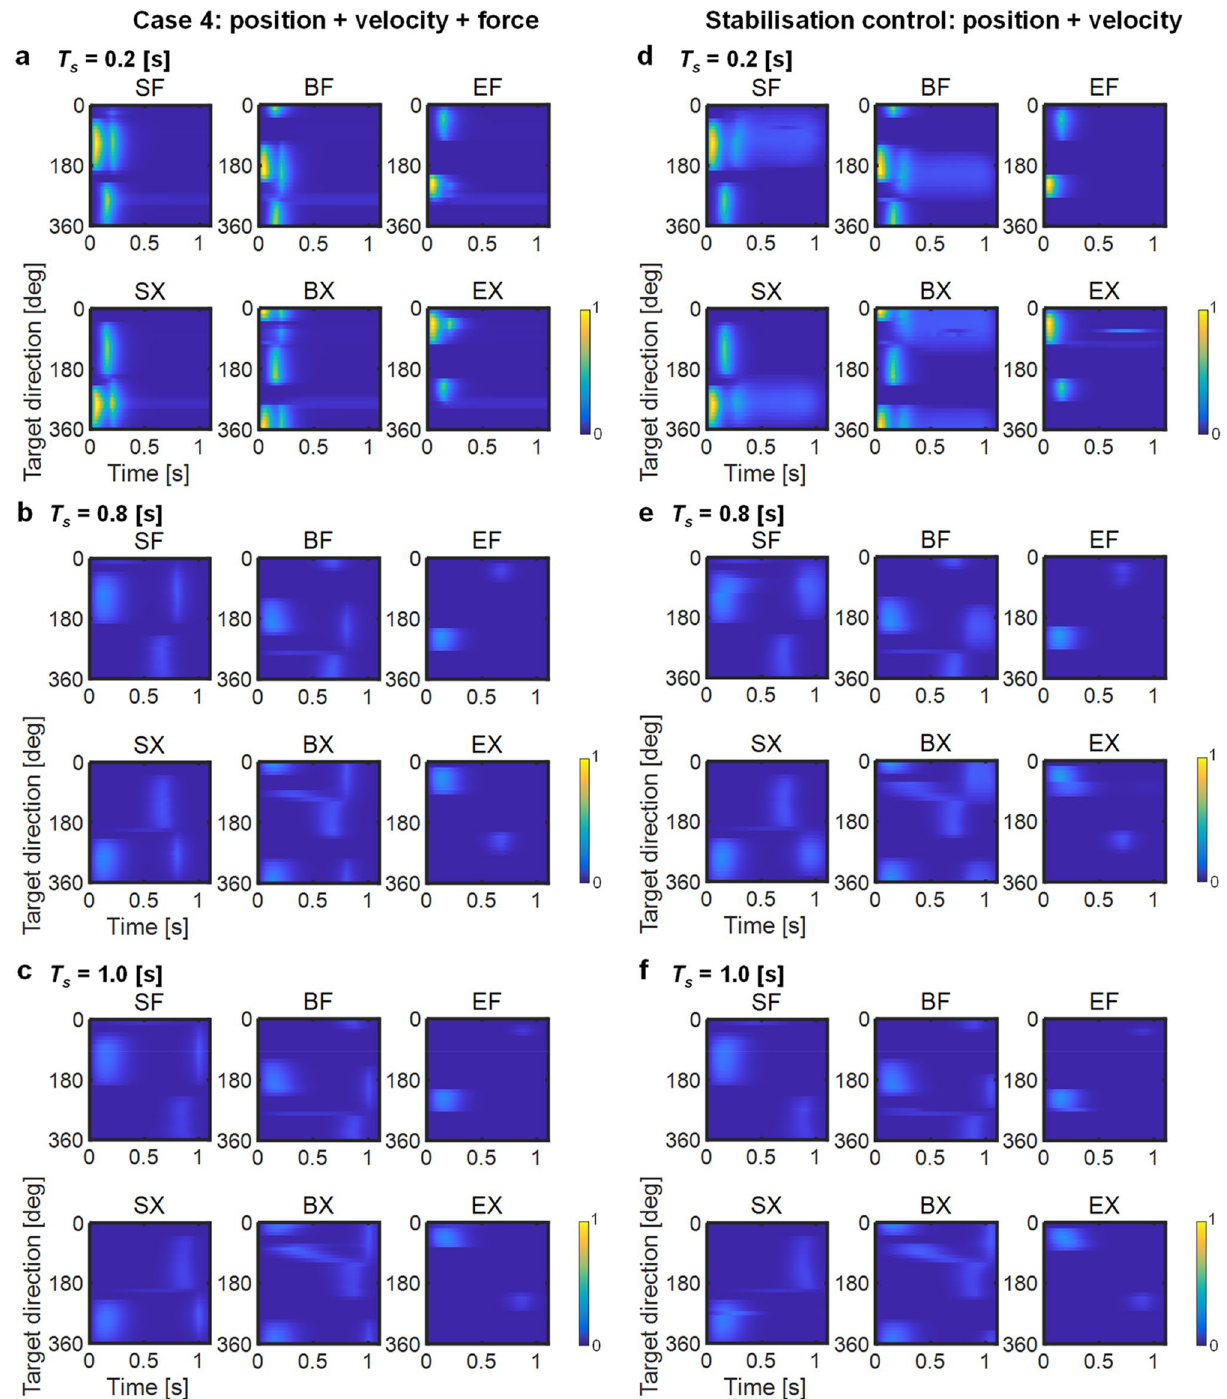
Figure 6. Changes of muscle activation patterns in relation to movement duration. Muscle activation patterns of movement times at 0.2, 0.8, and 1.0 s are shown from top to bottom, respectively. Case 4 and the stabilisation control are shown in ( a – c ) and ( d – f ), respectively. Values were normalised using the highest activation level in each muscle across all movement durations, ( a – c ) SF, 0.64; SX, 0.68; BF, 0.45; BX, 0.45; EF, 0.51; EX, 0.54, (d–f) SF, 0.57; SX, 0.61; BF, 0.42; BX, 0.42; EF, 0.47; EX,